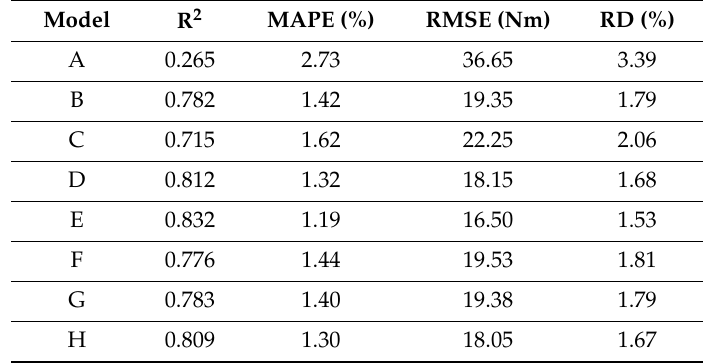
Table 10. Actual axle torque prediction performance results for each regression model.